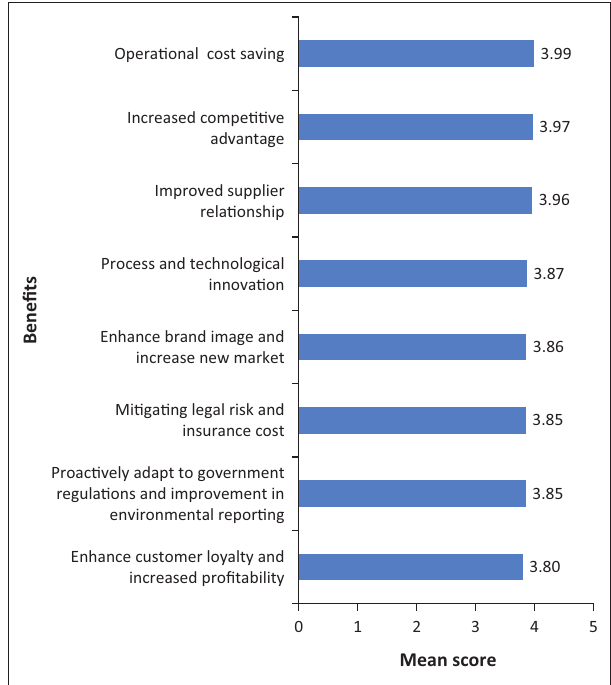
FIGURE 4: Benefits of implementing sustainable supply chain initiatives.